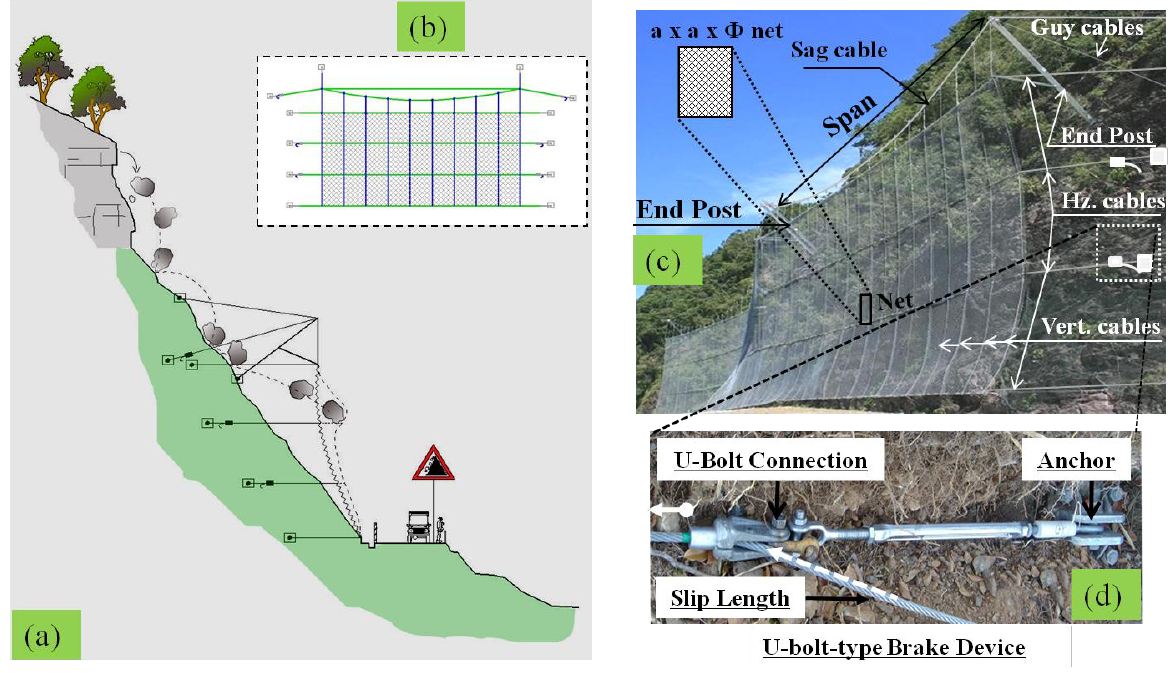
Fig. 1. LPR structure. (a) : schematic sectional side view of a typical LPR structure intercepting the falling rock-boulder in a mountain-road. (b) : front elevation of the typical LPR. (c) : LPR structural components illustrated over a picture taken from the real field installation. (d) : a UFD installed in the LPR; shown schematically in (c).